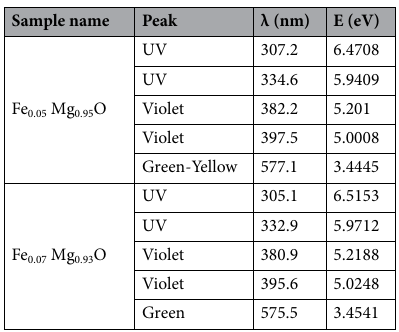
Table 2. The peak, wavelength, and energy band gap values of pure and different transition metal oxide concentrations-doped MgO